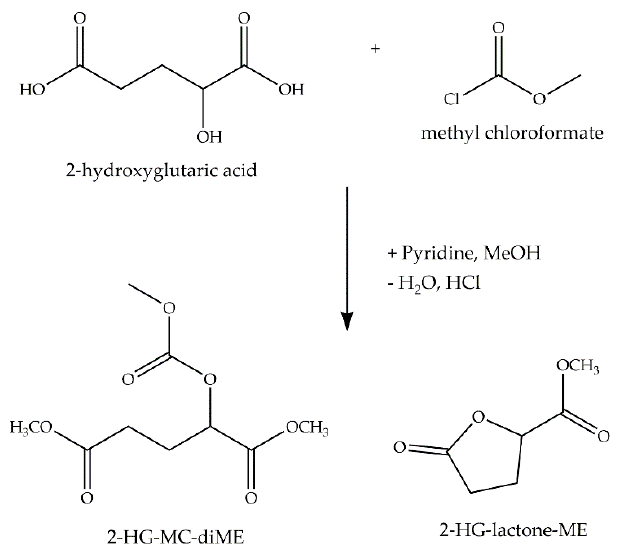
Figure 1. Reaction scheme for methyl chloroformate (MCF) derivatization of 2-HG. Derivatization of 2-HG with MCF/methanol yields two main derivatives, the three-fold derivative of the open 2-HG and the one-fold derivative of the 2-HG-lactone (MC: methoxycarbonyl group; ME: methyl ester group).